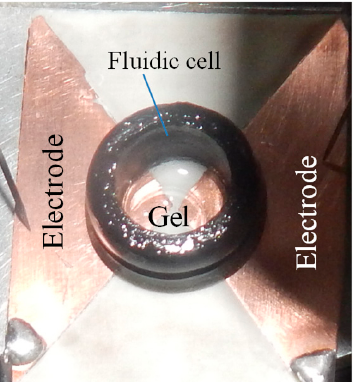
Figure 3. The device used for monitoring impedance changes of the hydrogel as the hydrogel responds to chemical concentrations.